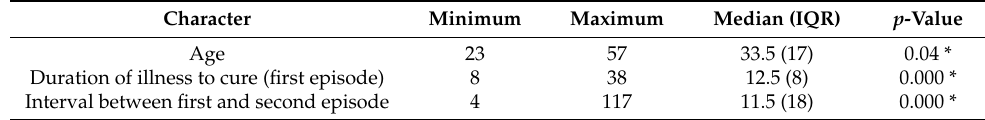
Table 1. Demographic characteristics of the participants ( n = 22).